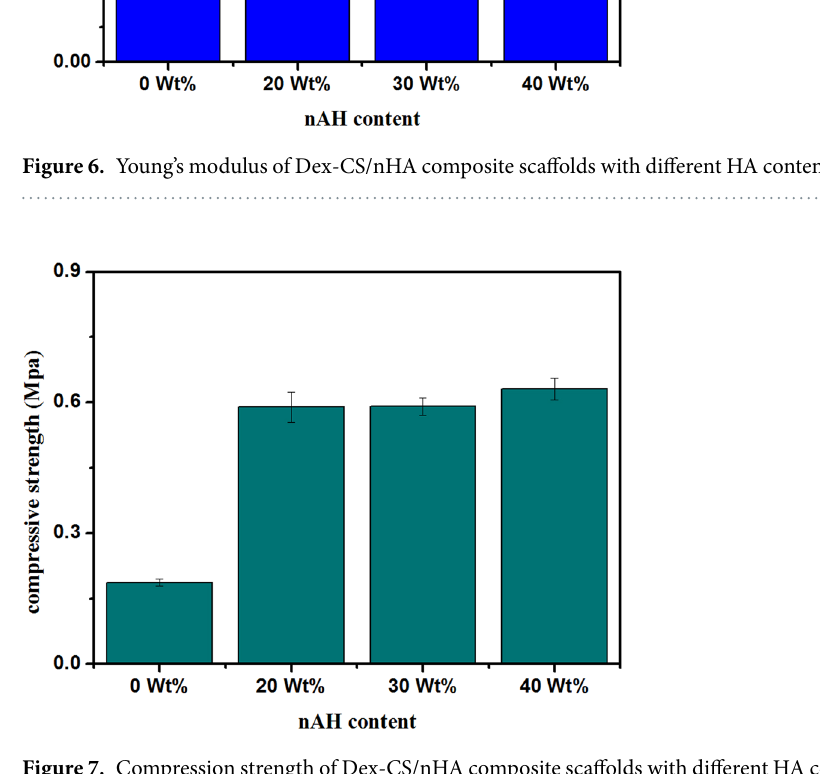
Figure 7. Compression strength of Dex-CS/nHA composite scaffolds with different HA